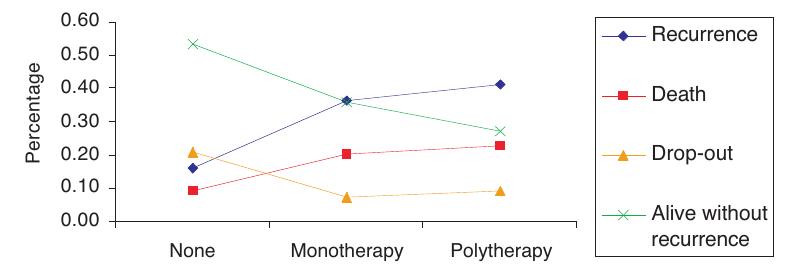
Figure 4 Percentage of patients with recur- rence, death or drop- out at six months in relation to AED treatment. prescribed acutely.